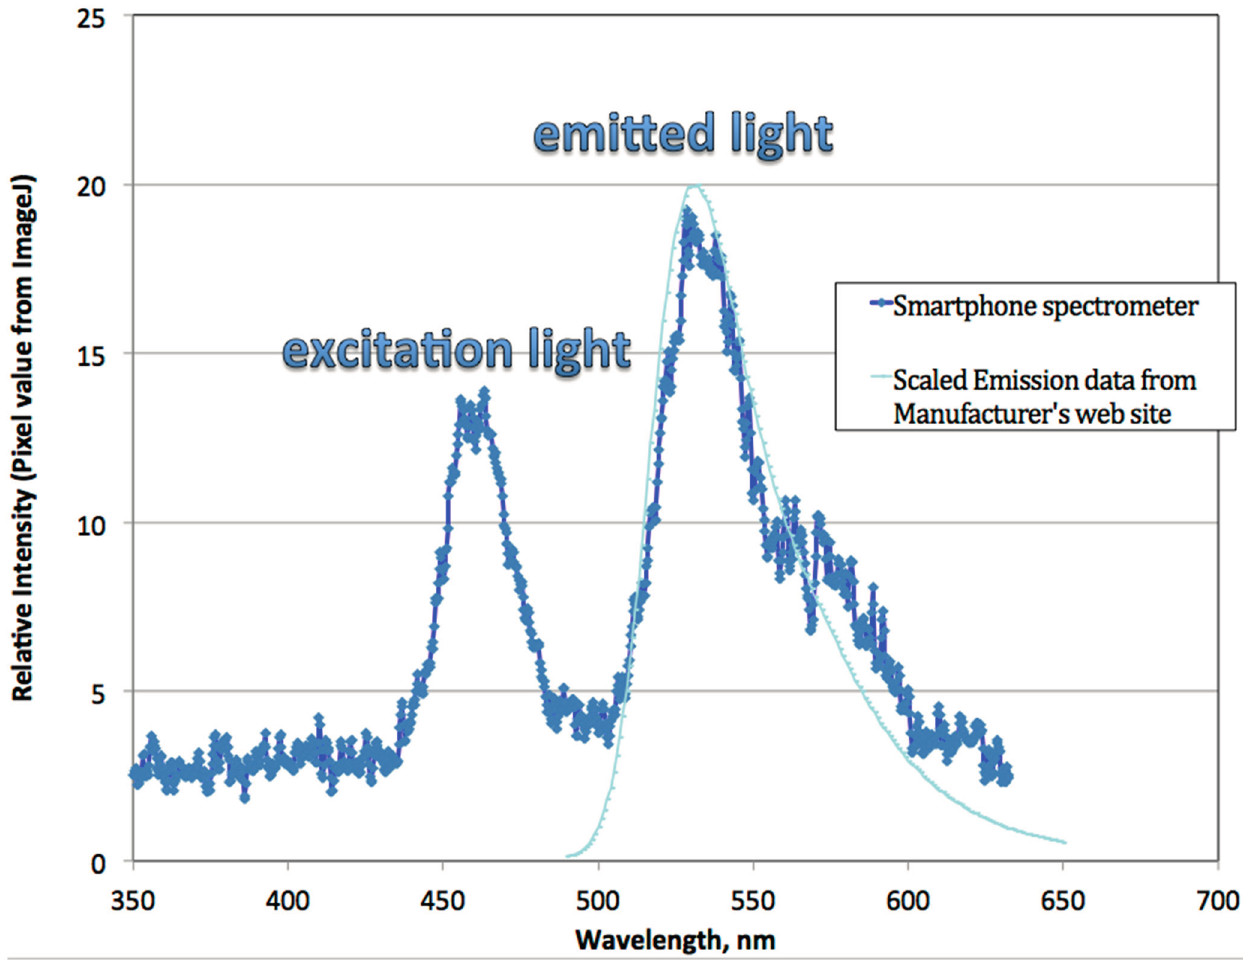
Figure 3. Smartphone fluorimeter spectra resolving the excitation and emitted light and compared to graphed data from the distributor of Sodium Green Tetra